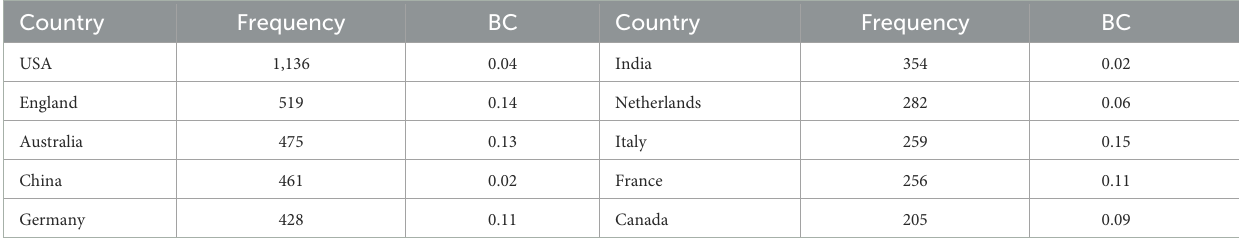
TABLE 1 Top 10 countries based on